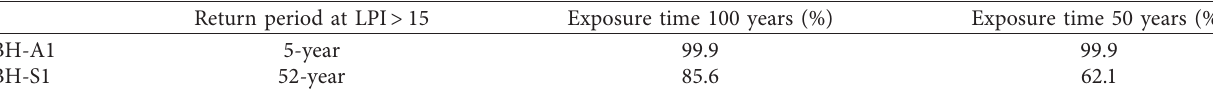
Table 4: Probability of LPI > 15 during different exposure time